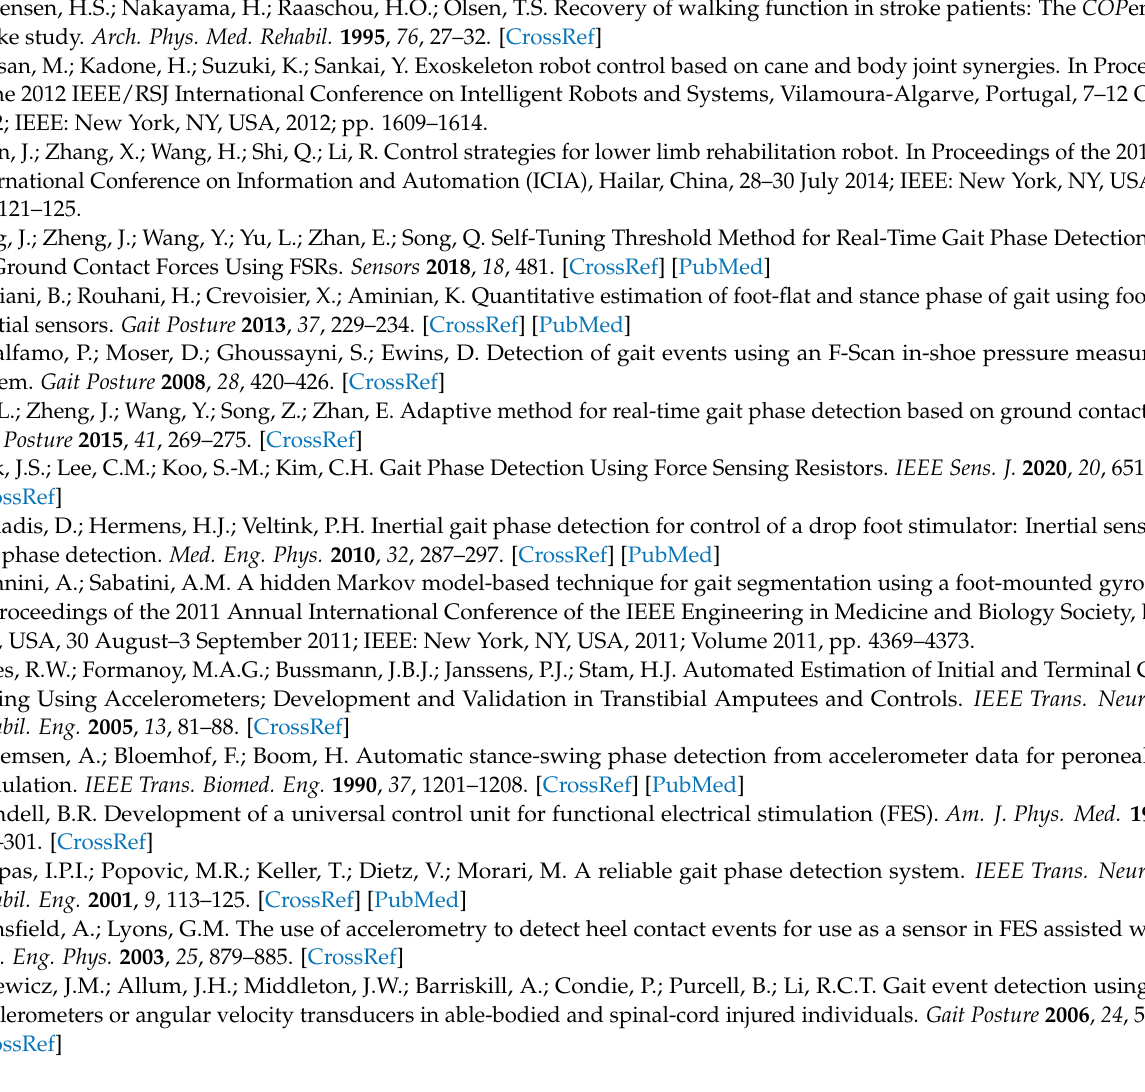
Figure A2. Comparison of approximate entropies of the 𝐶𝑂𝑃(cid:4662) .